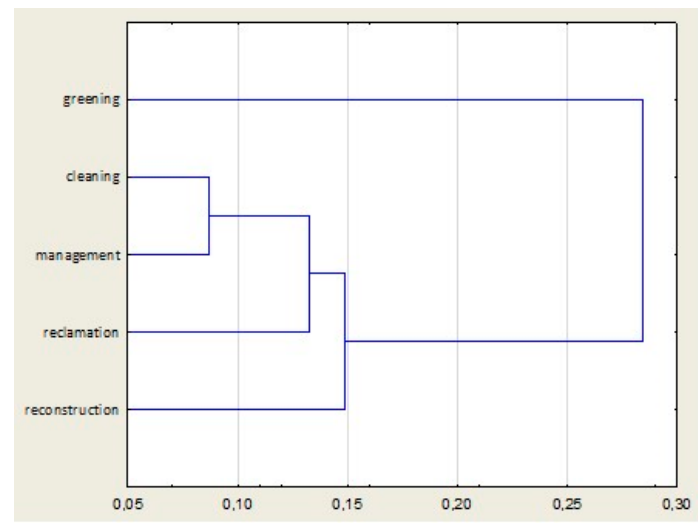
Figure 11. Grouping of the assessment indicators of possible actions aimed at improving the landscape (EnvEng and CivEng students combined, n = 244).